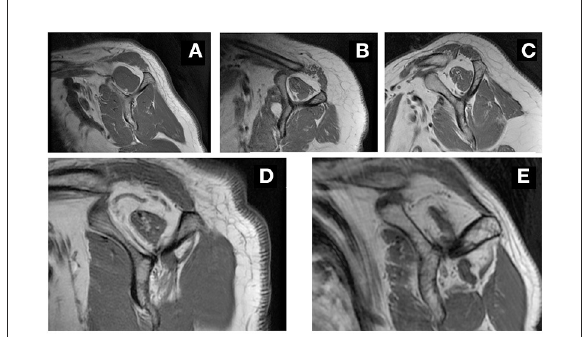
FIGURE1 Representative MRI image in grading fatty infiltration. Sagittal oblique views in T1-weighted MRI, showing grade 0 (A) , grade 1 (B) , grade 2 (C) , grade 3 (D) and grade 4 (E) fatty infiltration of the supraspinatus muscle.